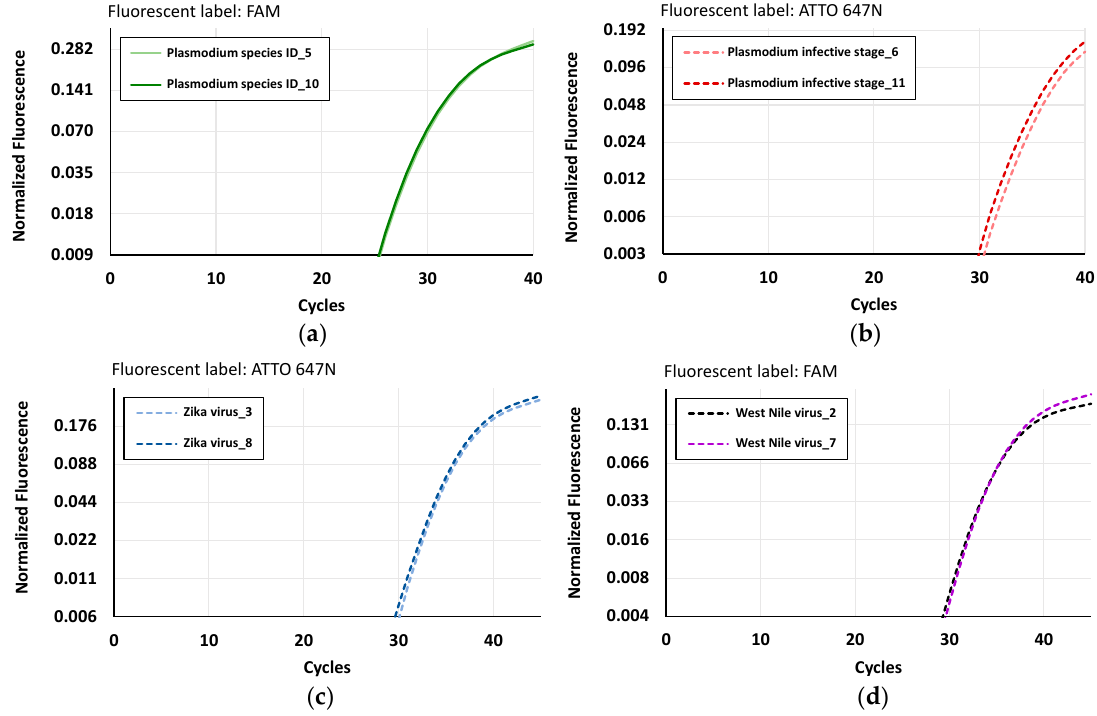
Figure 6. Representative LabDisk real-time PCR, acquired from the analysis of purified RNA for the various targets of the NA Study. ( a ) Pf species ID (DNA); ( b ) Pf infective stage (RNA); ( c ) ZIKV (RNA); ( d ) WNV-Lineage 1 (RNA). Each VectorDisk graph has two curves because each assay was included in two reaction chambers per disk (indicated in the figure legends). Table 4. Overview of the true positive (TP), false negative (FN), true negative (TN), and false positive (FP) rates for each assay and for each sample, as well as in total for the NA study. The numbering in the first column indicates the VectorDisk reaction chamber where an assay is expected positive or negative. The grey horizontal shading in some assay rows (accompanied by the symbol ‘ - ‘) means that neither positive nor negative signal was expected, because the primer/probe mixtures stored in these chambers were expected to give signals in other detection channels. The coloring of the columns ‘WNV-Lineage 1 ′ , ‘ZIKV’, and ‘PF-INF’ corresponds to the coloring of Figure 2. ‘PF-INF’ represents the mixture of P. falciparum DNA + P. falciparum infective stage RNA.